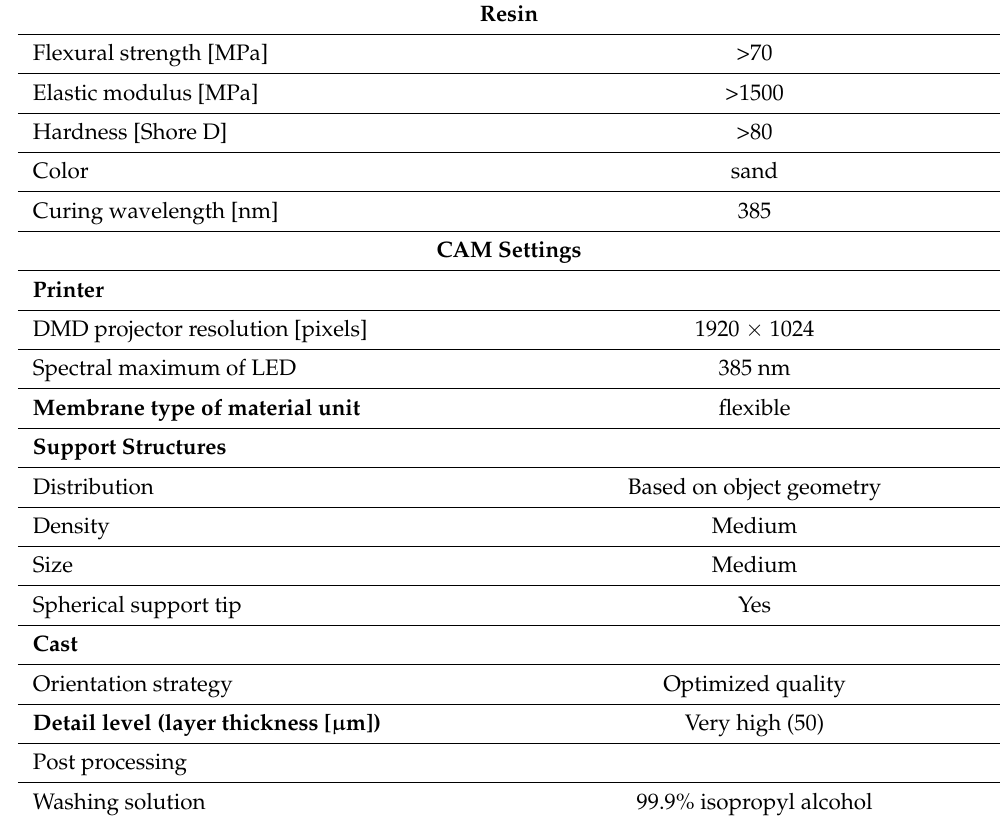
Table 1. Three-dimensional (3D) printing parameters